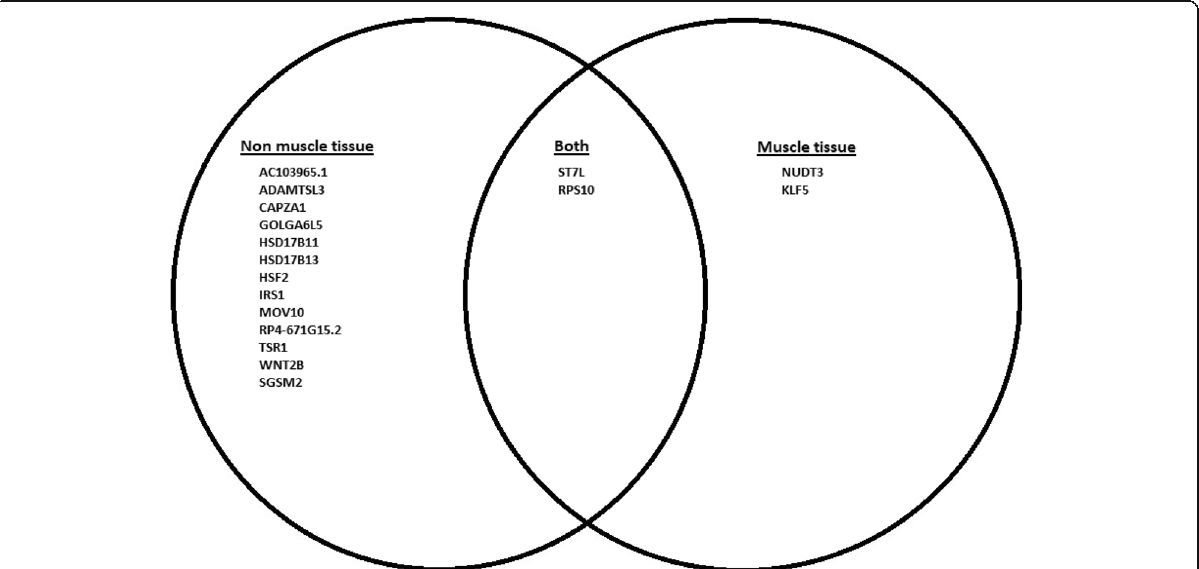
Fig. 2 Gene expression based on SMR of GTEx eQTLs and appendicular lean mass